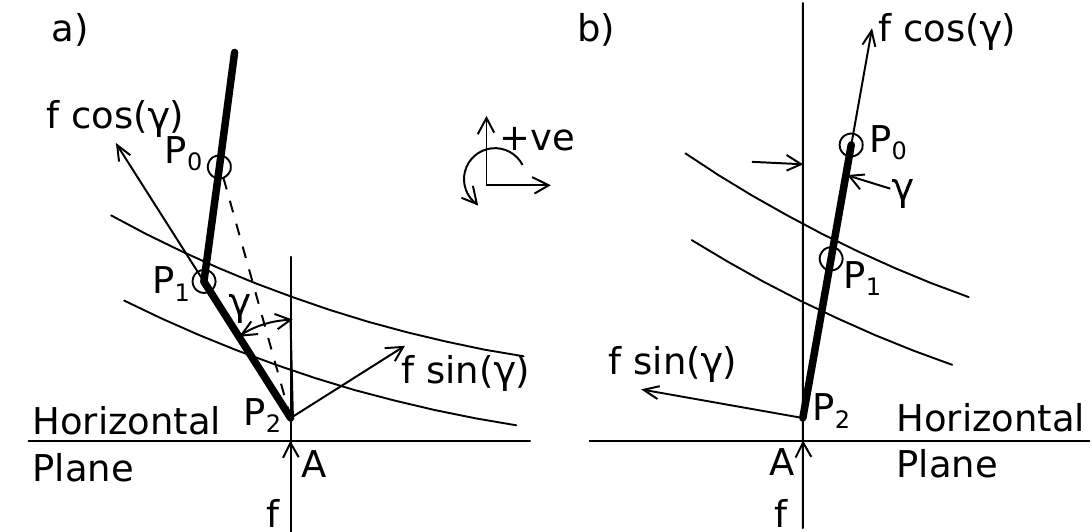
Figure 6. Force equilibrium diagram when link 2 touches the horizontal plane ( a ) link 1 and link 2 are not parallel; ( b ) link 1 and link 2 are